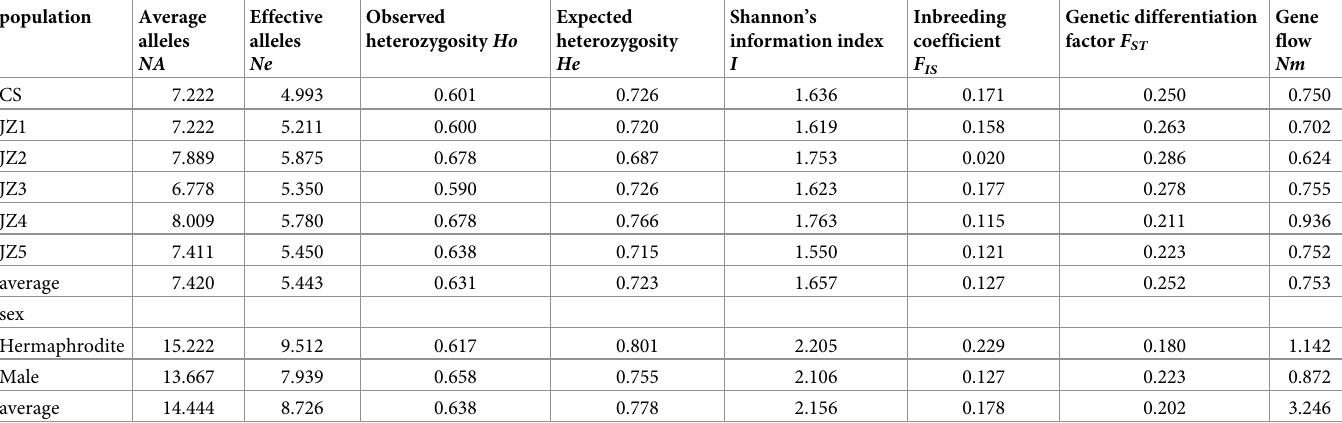
Table 8. Genetic variation statistics of different populations and the two sexual